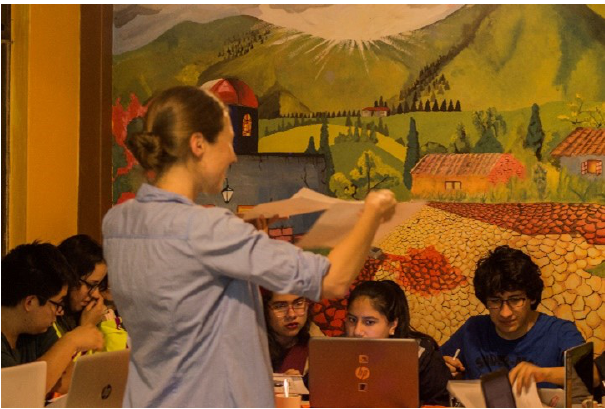
Professor Ana Foster from Universidad Yachay Tech, hands worksheets to students to review concepts on geophysical and monitoring principles.